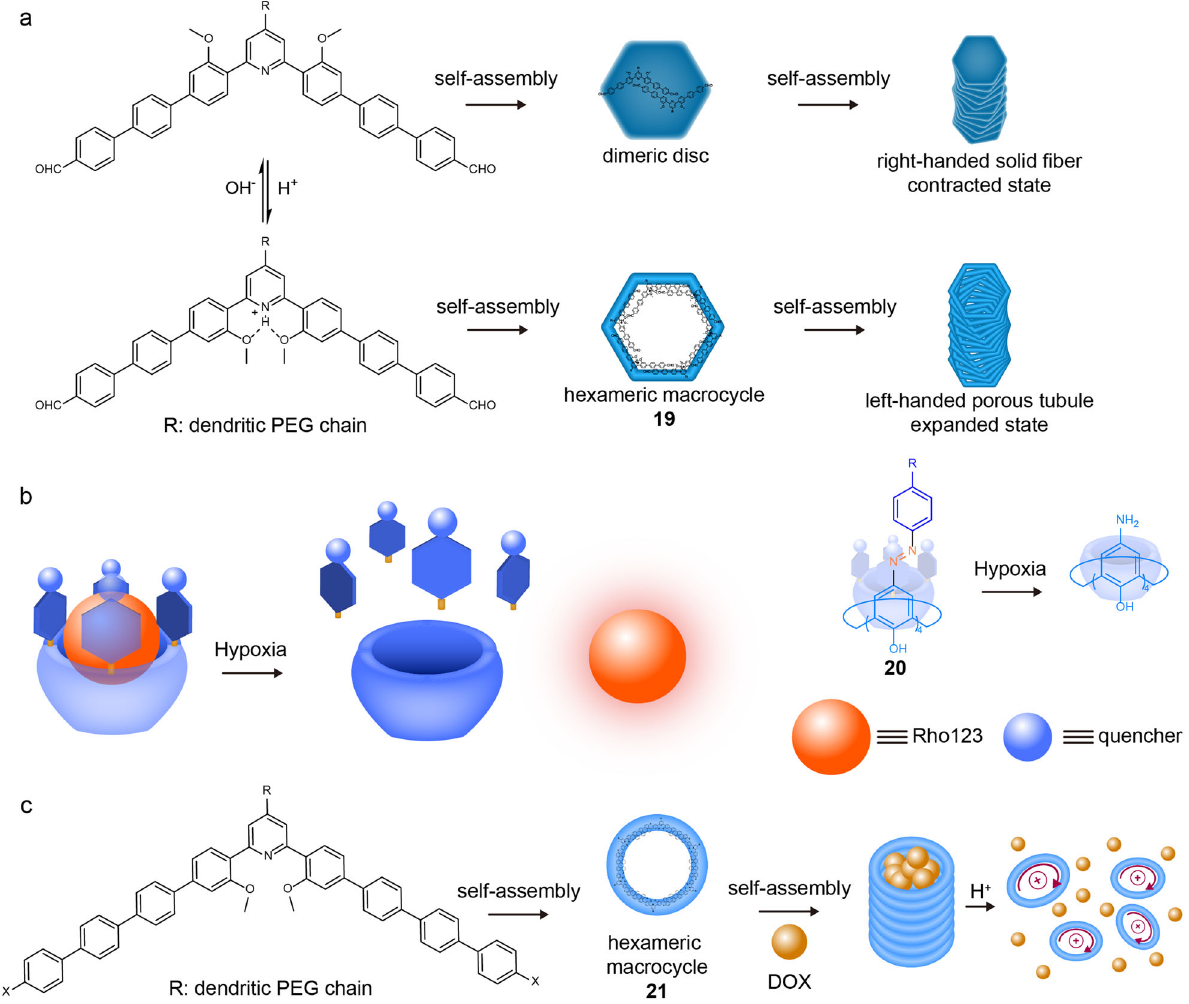
Fig. 6 RMs for guest encapsulation and controlled release. a the chemical structure of bent-shaped aromatic ligand, the self-assembly process under reversible acid/base-induced isomerization to form hexameric macrocycle 19 from dimeric disk and the further morphology changing process from right- handed solid fi bers to left-handed hollow tubules 67 . b the chemical structure of the macrocycle 20 and the representation of hypoxia-responsive imaging mechanism 68 . c the chemical structure of the macrocycle 21 , the disassembly and further drug release process of the formed nanotubes after protonation of pyridyl site during the environmental pH changes 70